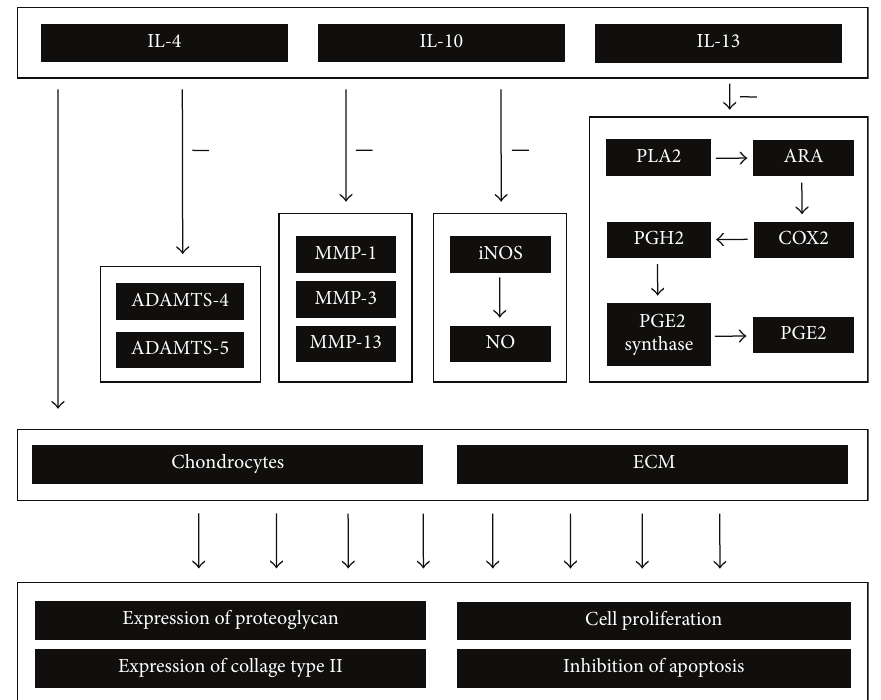
Figure 4: Schematic of the anti-inflammatory and chondroprotective effect of IL-4, IL-10, and IL-13 on articular cartilage during the course of